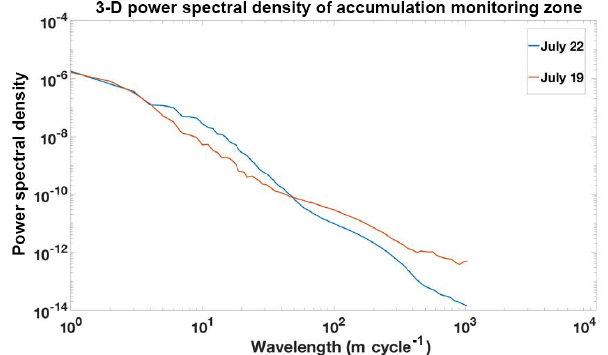
Figure 5. Power spectral density periodogram of the region of snow accumulation taken from the rover before and after the storm. The power changes from low frequency to high frequency after the high wind speeds sculpt steeper, shorter wavelength